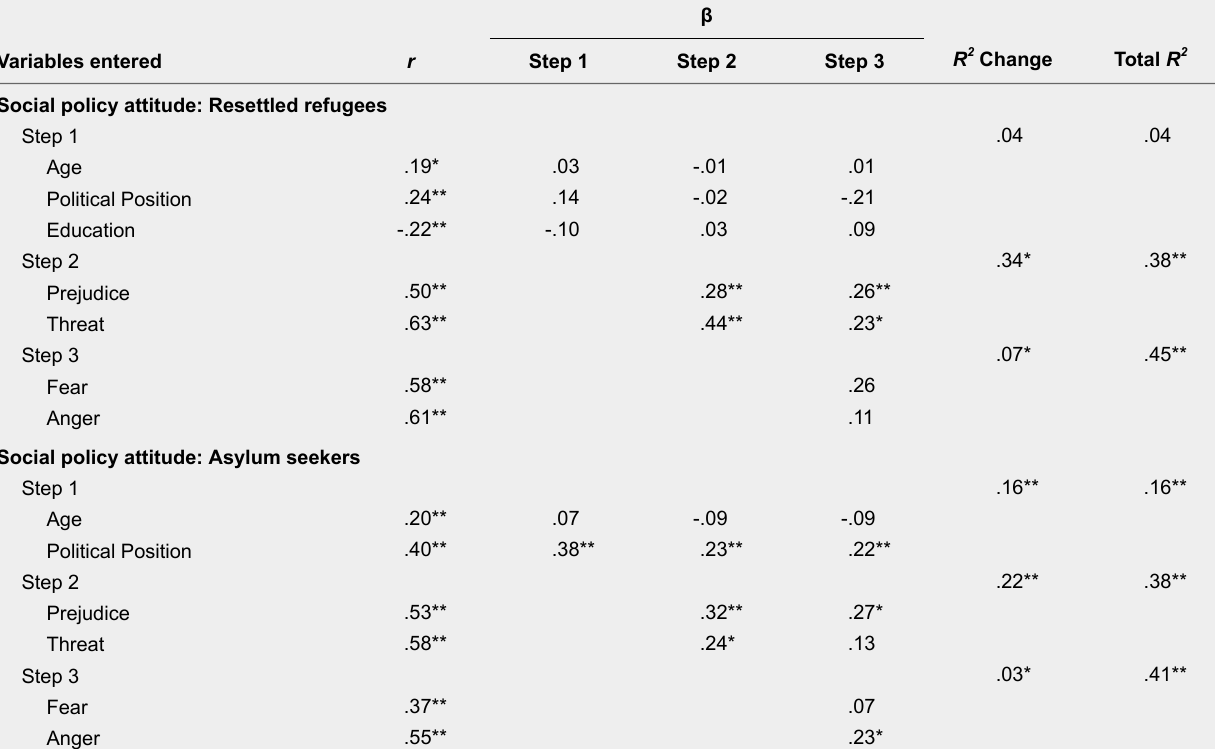
Hierarchical Regression Predicting Social Policy Attitude Towards Resettled Refugees and Asylum